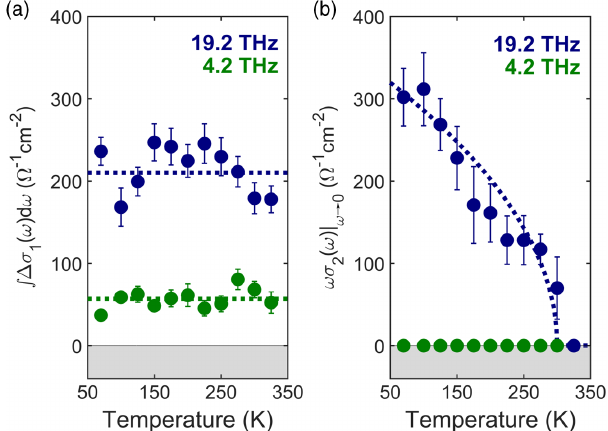
FIG. 5. Temperature dependence of the dissipative and super- conductinglike responses. Temperature-dependent (a) dissipative R Δσ ð ω Þ d ω and (b) superconductinglike response response 1 ωσ ð ω Þj 2 ω → 0 , measured for resonant narrow-band excitation of the lowest-frequency (4.2 THz) and highest-frequency (19.2 THz) phonon modes. The dashed lines are guides to the eye. As in Fig. 4, all data were taken with a pump fluence of 8 mJ = cm 2 (corresponding to approximately 3 MV = cm peak electric field).